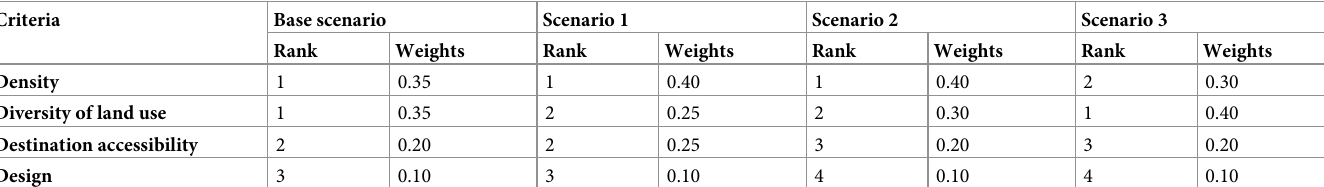
Table 4. Criteria’s weightage with index based on different